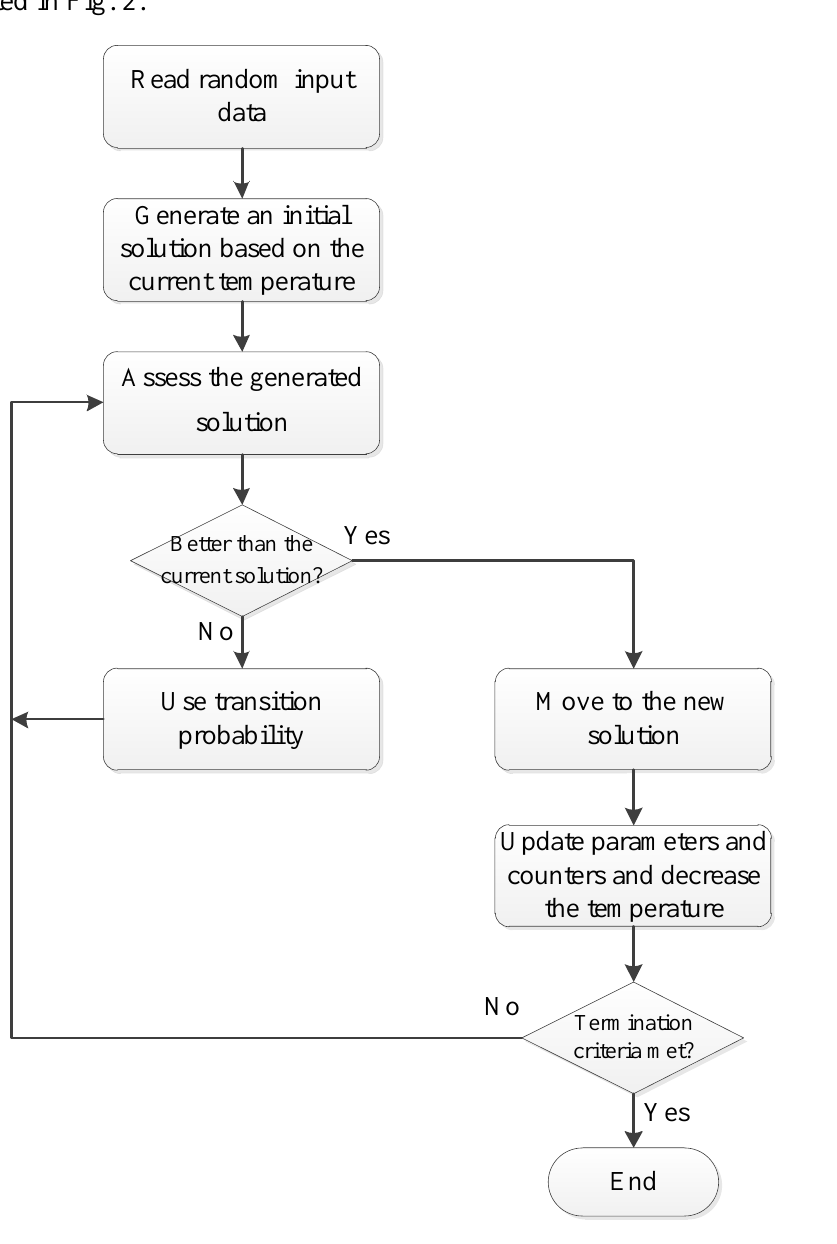
Fig. 2 Flowchart of SA